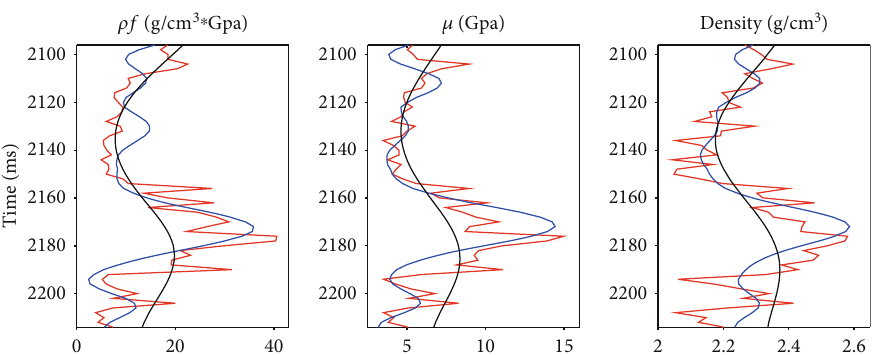
Figure 9: Comparison of inverted results at location of Well A. The black line indicates the initial model data, the red line indicates the real seismic well logging curve, and the blue line indicates the inversion